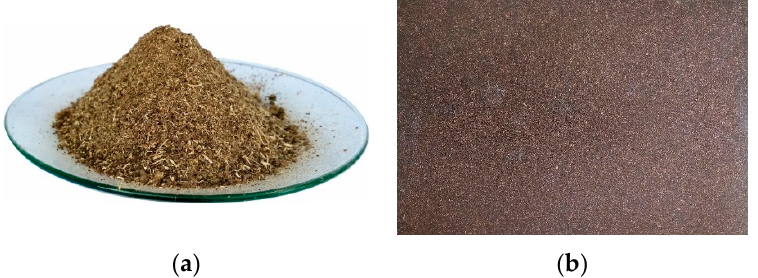
Figure 3. ( a ) Dry-compounded feedstock and ( b ) sample board, after hot-pressing at 180 °C for 30 min. Table 1. Blending ratios and time–temperature-mix treatments of WPCs at S (0.31 mm) and L (0.47) particle sizes. Particle size S Blending Press Ratio Temperature (wt. %) for the smaller graded particles obtained from the 90 min blending cycle. For a better de-